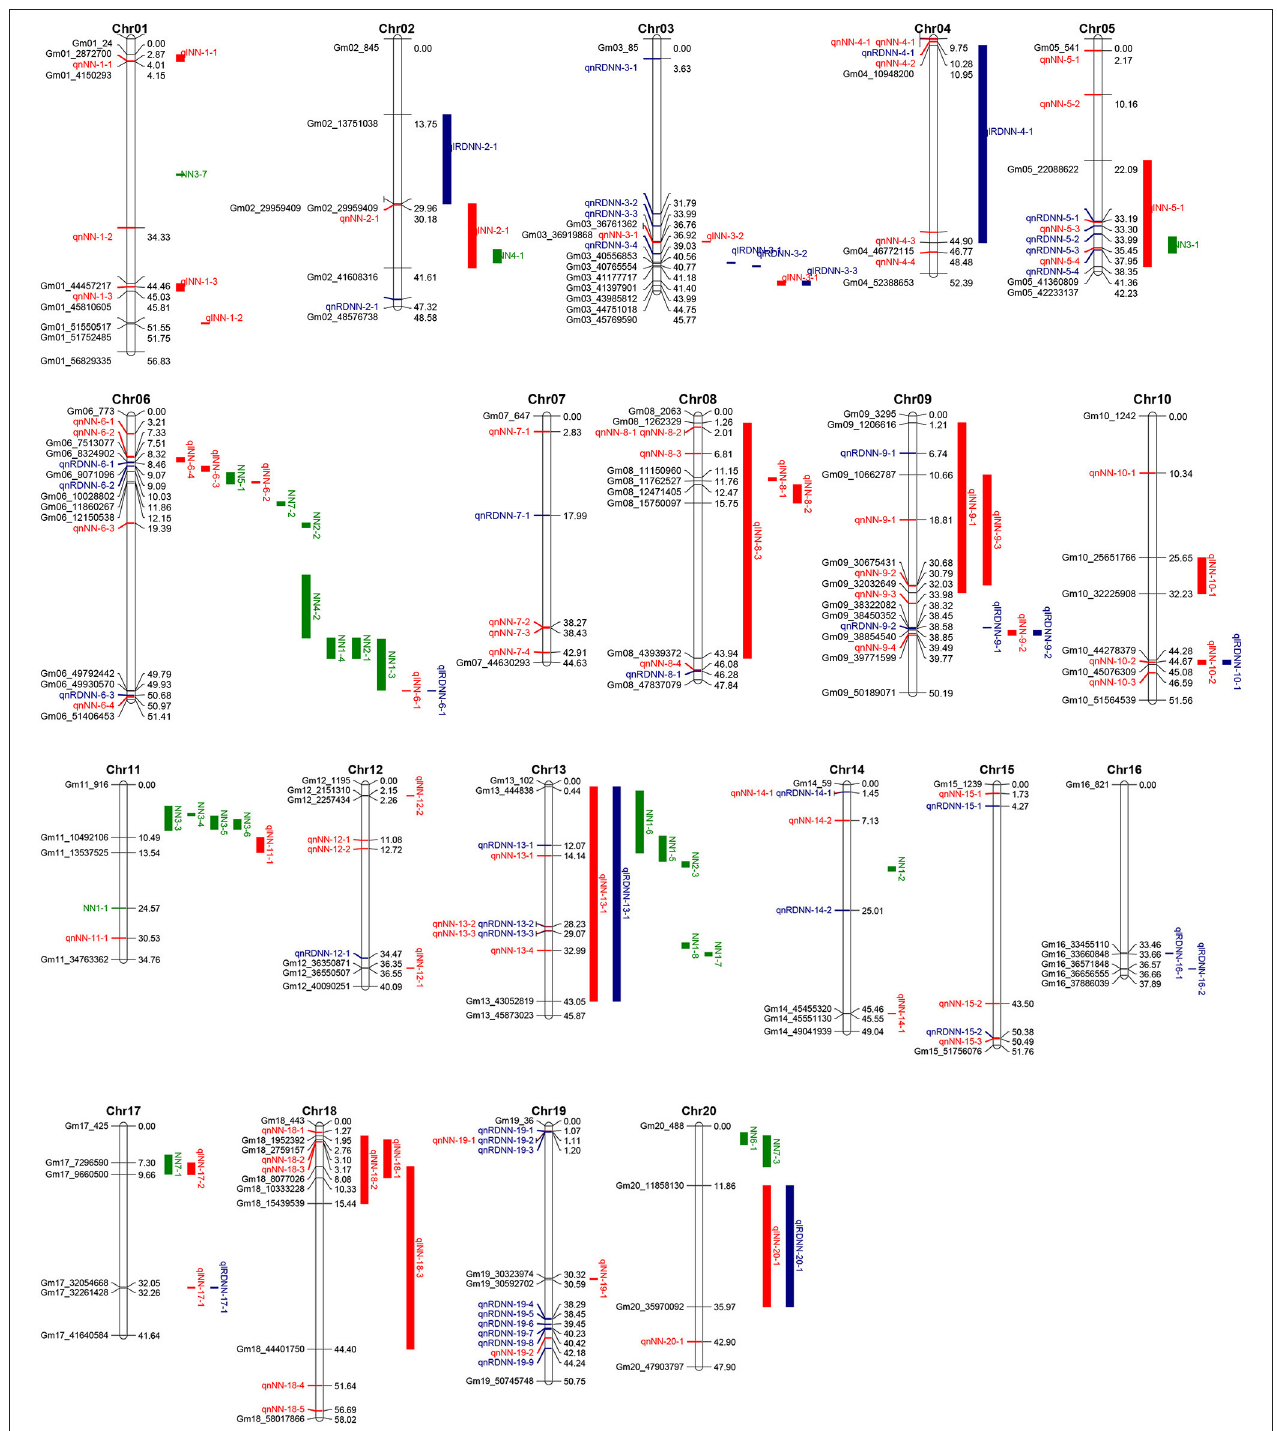
FIGURE 3 | Distribution of quantitative trait loci (QTL) underlying main stem node number (MSNN) on 20 chromosomes. The red and blue colors represent QTL controlling NN and response to density change identified in present research, respectively, and the green color represents QTL underlying NN identified in previous research listed in Soybase